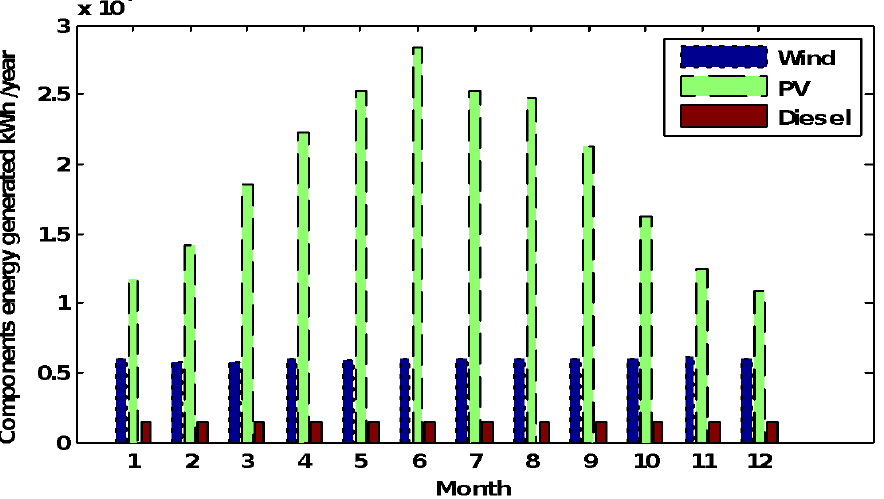
Figure 8. Load profile sharing using MG components with 6884 kg emissions constraints